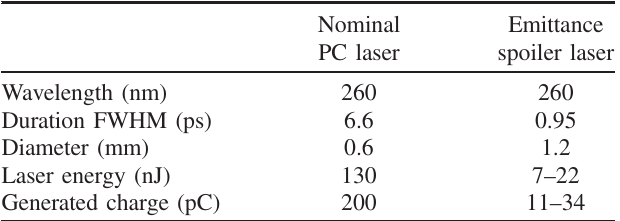
TABLE II. Parameters of the two laser